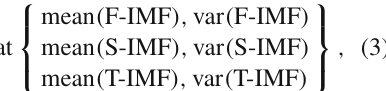
signal and its FT-IMF component. c The ma-contaminated signal and its FT-IMF component. d The em-contaminated signal and its FT-IMF